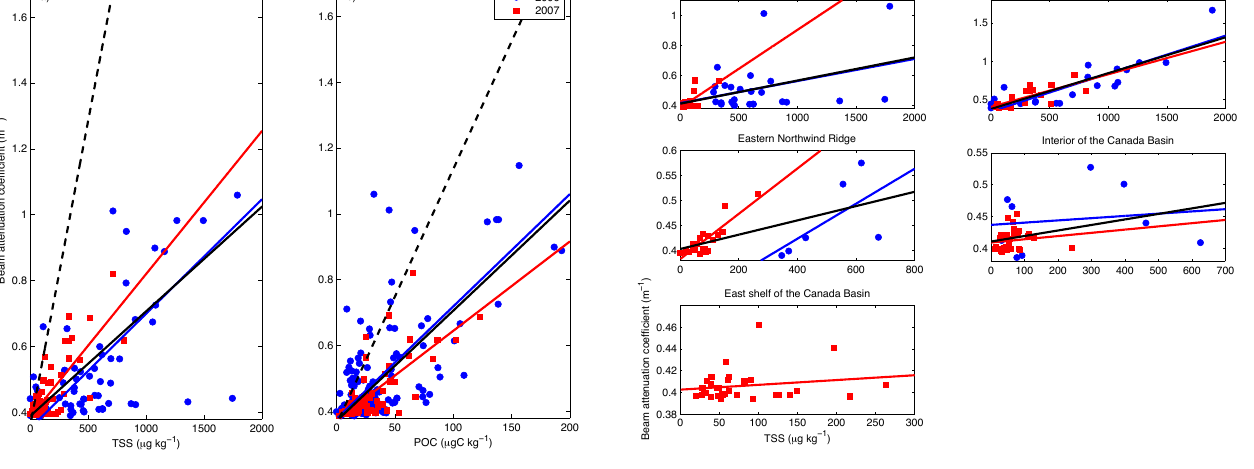
Fig. 14. Linear least squares regression of (a) the relationship be- tween beam attenuation coefficient and total suspended solids, and (b) the relationship between beam attenuation coefficient and par- ticulate organic carbon. The blue dots represent samples taken in 2006 and the red squares are samples taken in 2007. The blue and red lines represent the line of best fit for 2006 and 2007, respec- tively. The solid black line represents the line of best fit from both years together and the dashed black line represents the linear regres- sion (bac = 0.00755(POC) + 0.36 and bac = 0.00185(TSS) + 0.36) from Bishop (1999) based on JGOFS Equatorial Pacific data.